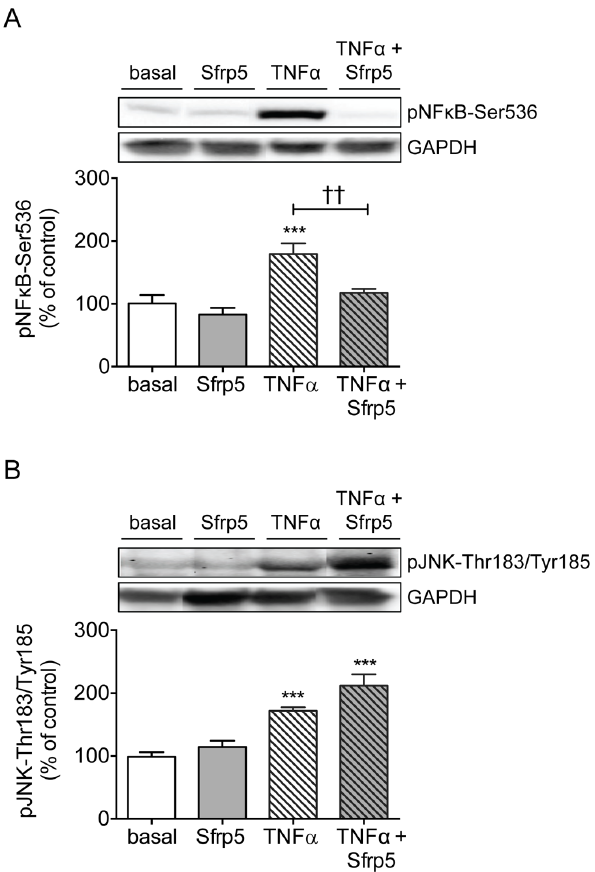
Figure 5. Effect of Sfrp5 and TNF a on inflammation signaling in primary human adipocytes. Primary human adipocytes were kept untreated, exposed to Sfrp5 for 24 h, or to 5 ng/ml TNF a for 24 h with or without a 4 h preincubation with Sfrp5. Cell lysates were analyzed for phosphorylation of NF k B-Ser536 (A) and JNK-Tyr183/Thr185 (B) by Western blotting. Phosphorylation signals were normalized for GAPDH protein abundance and expressed as mean 6 standard error of the mean of seven independent experiments using cells from different donors. The values obtained for untreated cells were considered as control and set at 100%. Differences among groups were calculated by ANOVA followed by Bonferroni multiple comparison analysis. ***, p , 0.001 versus untreated cells; {{ , p , 0.01 for the effect of Sfrp5 versus TNF a .